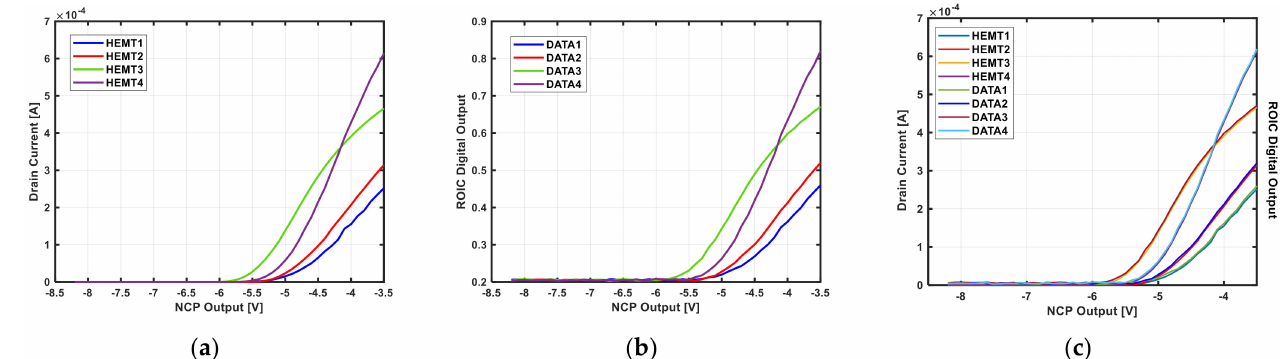
Figure 25. ( a ) HEMT device I-V curve; ( b ) digital output of ROIC; ( c ) comparison of ( a ) and scaled ( b ). Table 1. Measured error as a function of H 2 concentration. H 2 Concentration